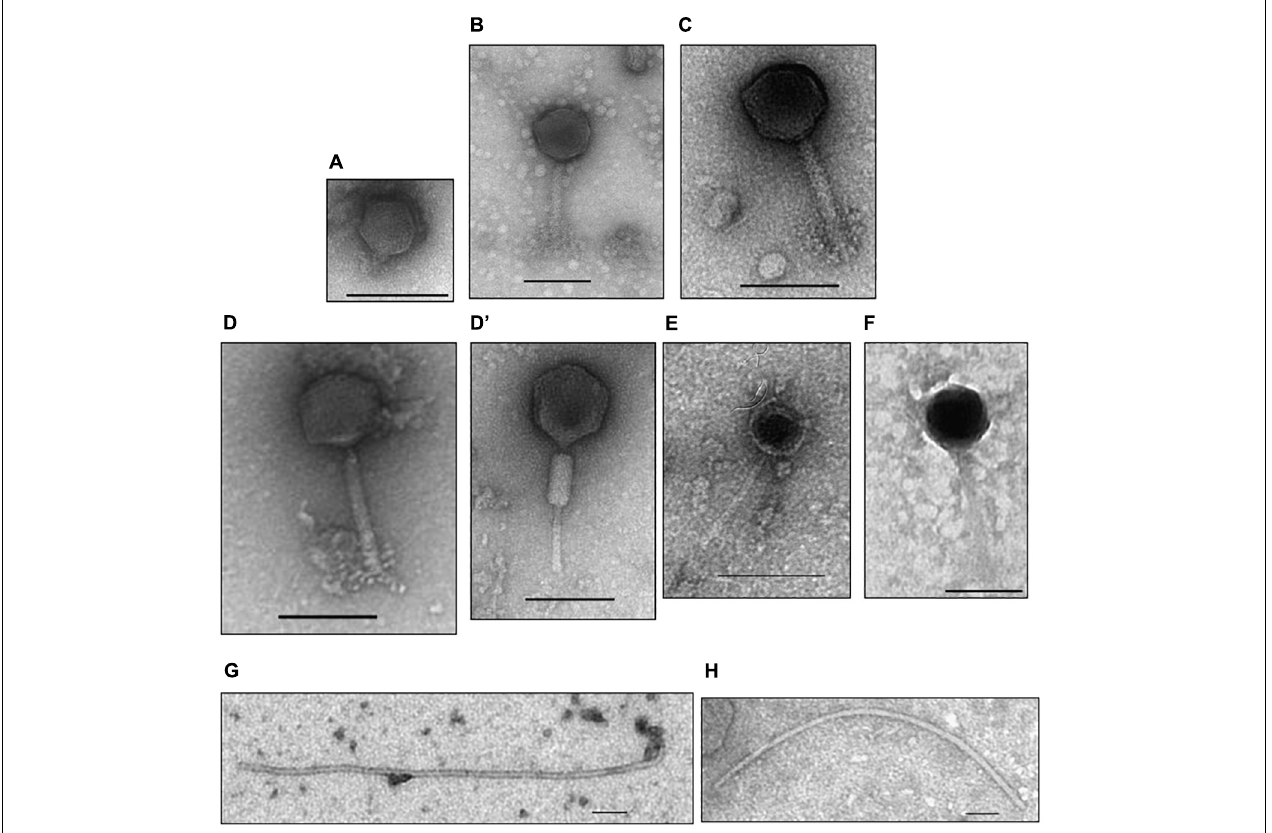
FIGURE 1 | Electron micrographs of Sinorhizobium meliloti bacteriophages isolated from the rhizosphere of the coastal legume Medicago marina . (A) P_ort11, (B) M_ort18, (C) M_sf1.2, (D,D’) M_sf3.33, (E) S _ sf3.10C, (F) S_sf3.53, (G) I_sf3.10T, (H) I_sf3.21. Phage particles were negatively stained with uranyl acetate. Scale bars represent 100